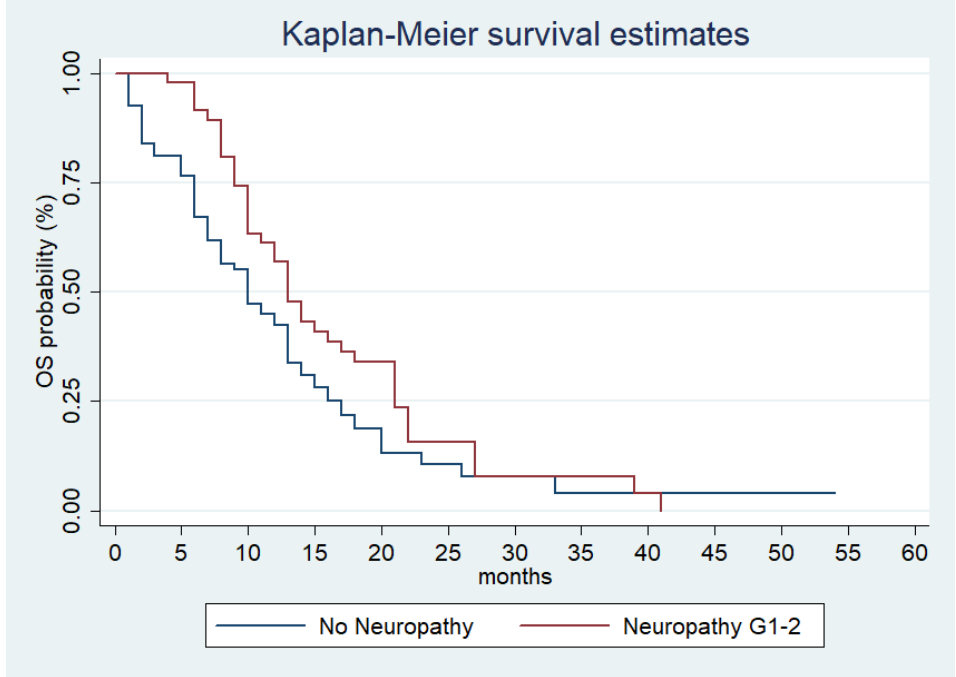
Figure 1. Estimated PFS for nab − Gem according to low-grade CIPN presentation. Meanwhile, OS was 13 months (95% CI (10–18 months)) and 10 months (95% CI (8– 13 months)) in patients with and without neuropathy (Figure 2, p = 0.04).